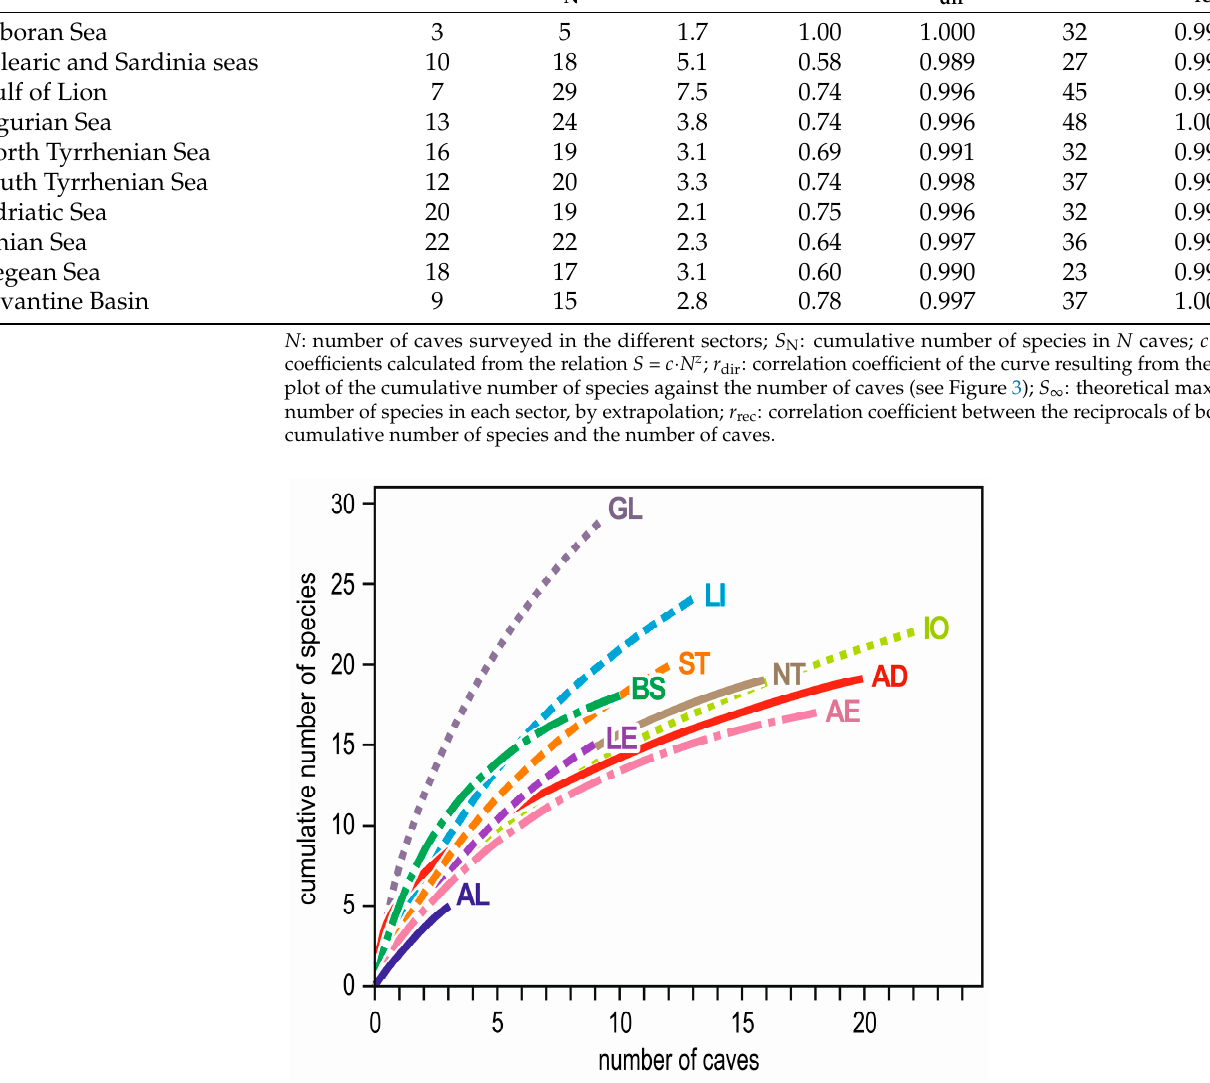
Figure 3. Species accumulation curves for cave decapods in ten Mediterranean Sea sectors. AL = Alboran Sea; BS = Balearic and Sardinia seas; GL = Gulf of Lion; LI = Ligurian Sea; NT = North Tyrrhenian Sea; ST = South Tyrrhenian Sea; AD = Adriatic Sea; IO = Ionian Sea; AE = Aegean Sea; LE = Levantine Sea (see Figure 1 for sectors